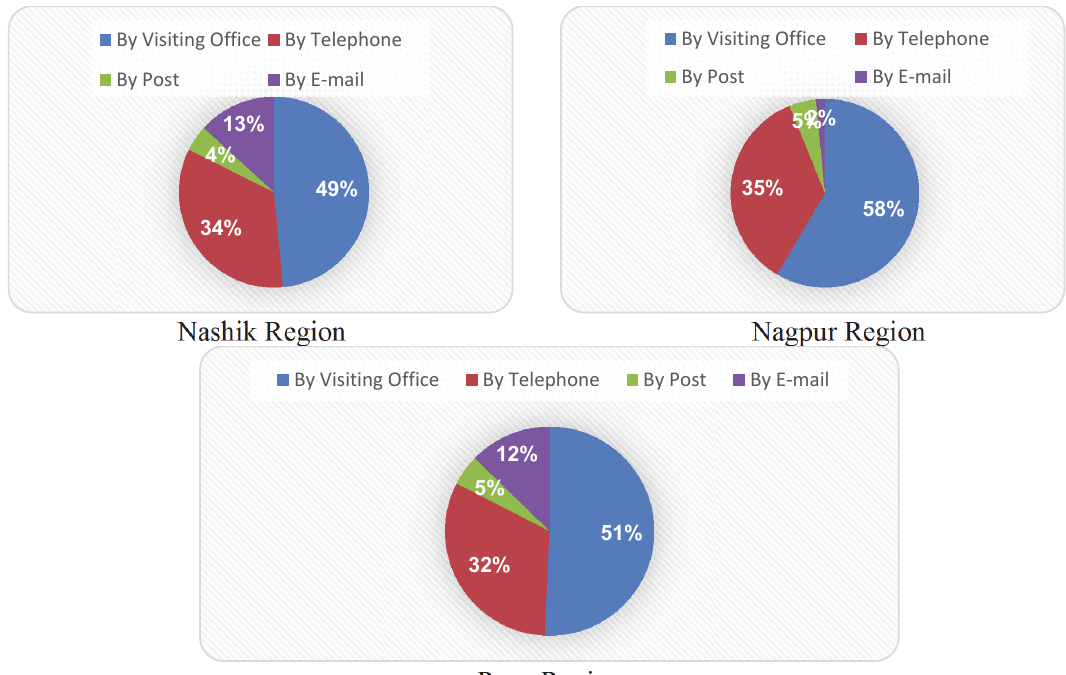
Fig. 2. Preferred mode of Communication with the